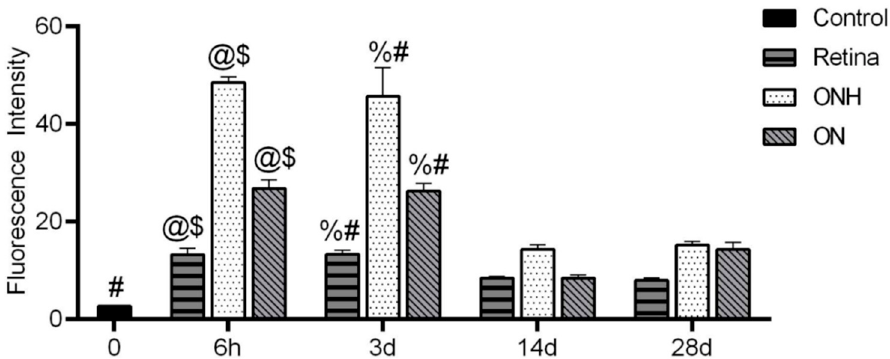
Figure 6. Hypoxia is highest in ONH and ON compared to retina. ON, ONH, and retina at each time point (6 h, 3 d, 14 d, and 28 d) showed significant tdT intensity compared to control (each timepoint and structure vs. baseline (#, p < 0.0001 except the following time points compared to control: 14 d retina ( p = 0.0328), 28 d ONH ( p = 0.0017), 14 d ONH ( p = 0.0030), and 28 d ONH ( p = 0.0010). ONH and retina tdT fluorescence intensity is significantly greater at each of the 6 h and 3 d time points as compared to the 14 d and 28 d time points (@$, p = 0.0001). ON tdT fluorescence intensity is significantly greater at 6 h compared to 14 d (@, p < 0.0001) and 28 d ($, p = 0.001) and is also greater at 3 d compared to 14 d (%, p < 0.0001) and 28 d (#, p = 0.0008). n = 6 ONHs and ONs at 6 h, 6 ONHs and ONs at 3 d, 6 ONHs and ONs at 14 d, 6 ONHs and ONs at 28 d, and 6 control ONHs and ONs.